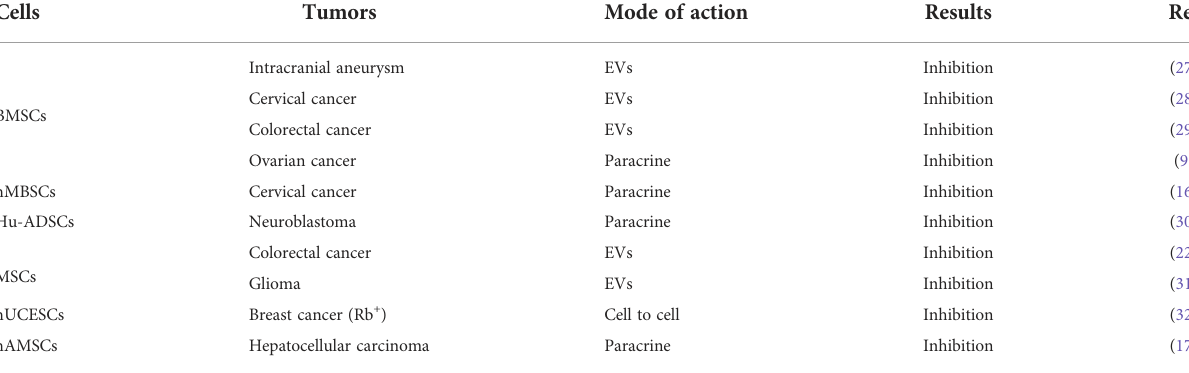
TABLE 2 The inhibitory effect of MSCs in cancers.